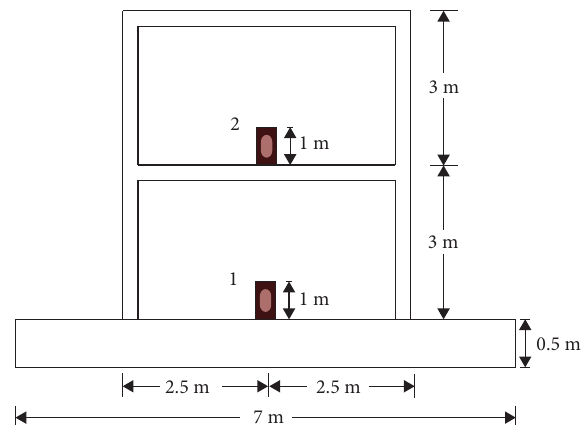
Figure 16: Locations of TNT